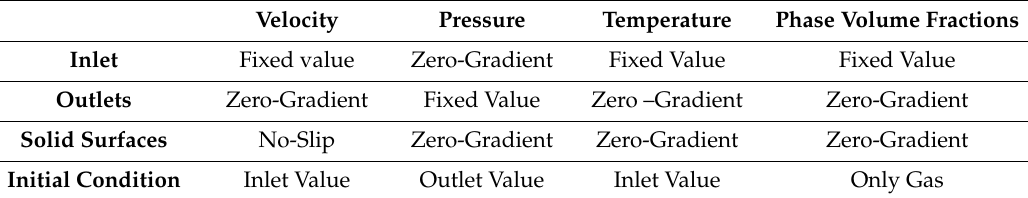
Table 2. Initial and boundary